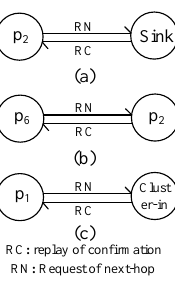
Figure 8. Message flow during path selection. ( a ) Message flow with Sink node; ( b ) Message flow with cluster head node; ( c ) Message flow with non-cluster node.